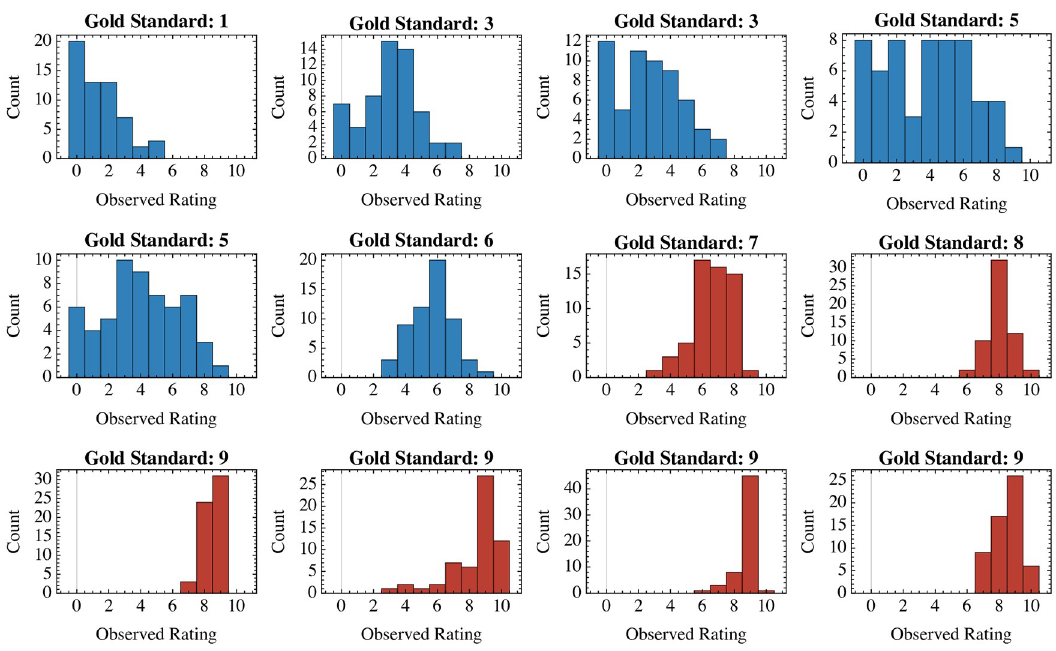
Fig 2. Histograms of ratings for each value of the ground truth Alda score available in the first wave dataset from Manchia et al. [1]. Each histogram represents the distribution of ratings ( n r = 59) for a single one of twelve assessment vignettes. The gold standard (“ground truth”) Alda score, obtained by the Halifax consensus sample, is depicted as the title for each histogram. Plots in blue are those for vignettes with gold standard Alda scores less than 7, which would be classified as “non-responders” under the dichotomized setting. Vignettes with gold standard Alda scores � 7 are shown in red, and represent the dichotomized group of lithium responders.